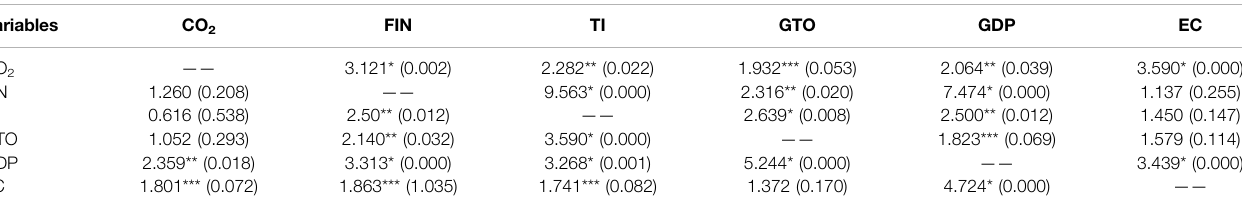
TABLE 7 | Panel Granger causality test results.